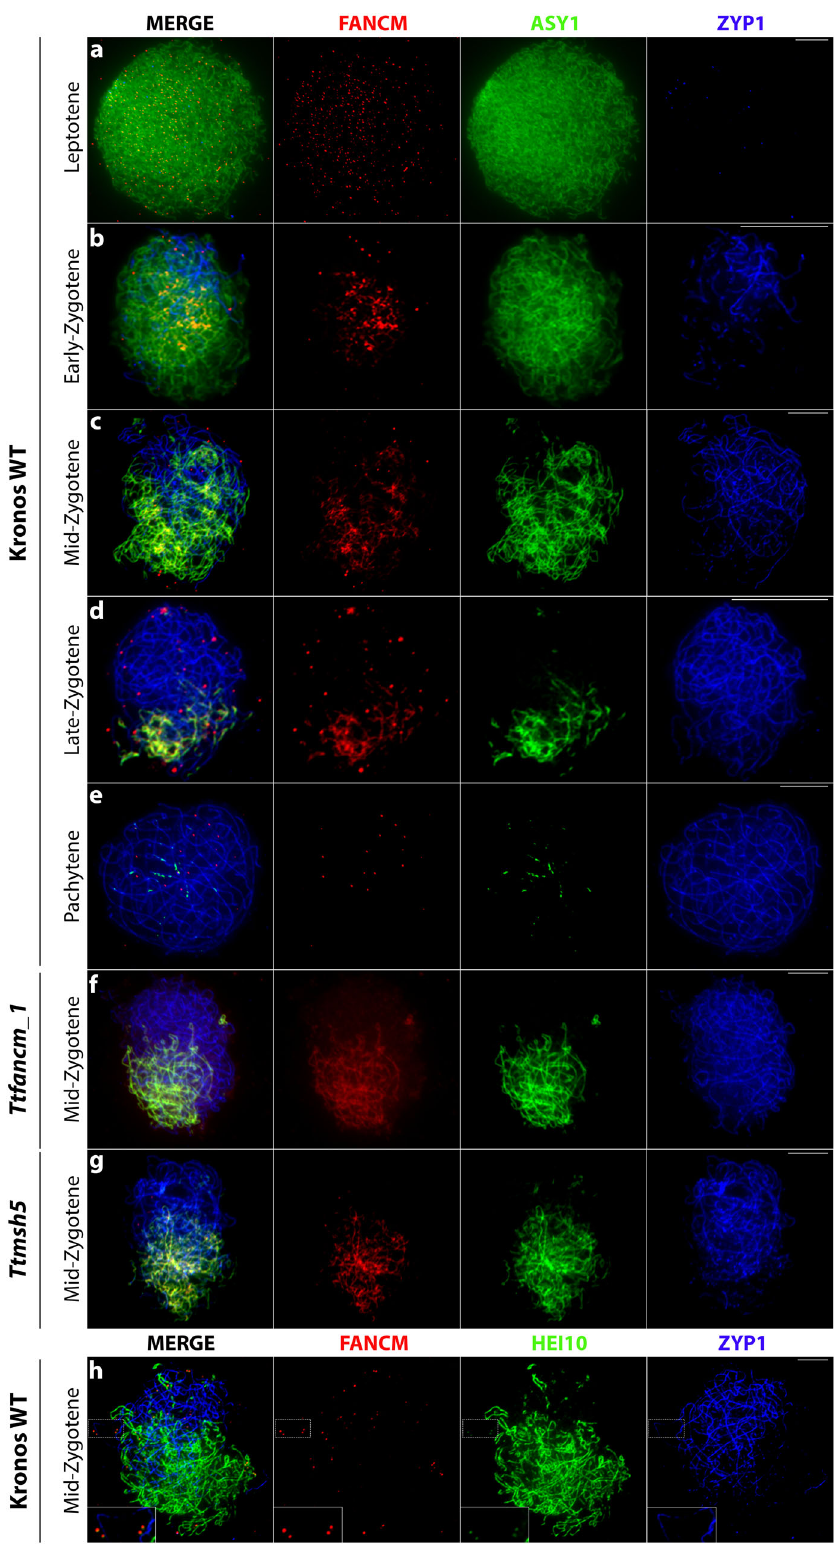
Fig. 4 FANCM localizes to meiotic chromosomes at prophase I. a – g Co-immuno fl uorescence of FANCM (red), ASY1 (green) and ZYP1 (blue) on meiotic prophase I chromosome spreads. h Co-immuno fl uorescence of FANCM (red), HEI10 (green) and ZYP1 (blue) on meiotic chromosome spreads at mid- zygotene. Representative micrographs are shown from replicates, ( a ) ( n = 5), ( b ) ( n = 22), ( c ) ( n = 29), ( d ) ( n = 11), ( e ) ( n = 12), ( f ) ( n = 16), ( g ) ( n = 20), ( h ) ( n = 5). Insets, 2× magni fi ed view of outlined region, showing co-localization of FANCM and HEI10 foci on synapsed chromosomes. Scale bars = 10 µ